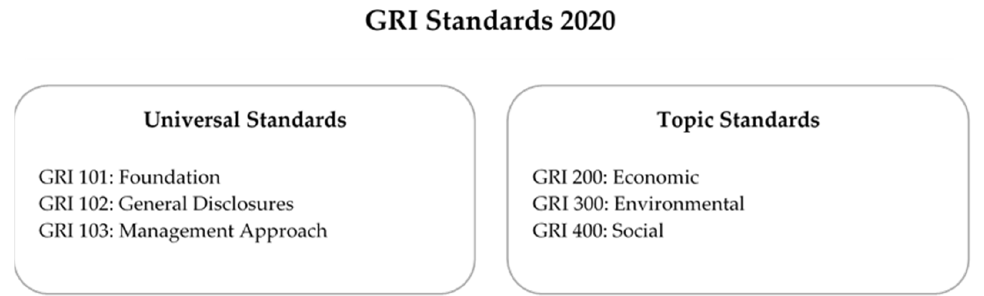
Figure 1. Overview of the GRI Standards 2020. Authors’ own figure adapted from Global Reporting Initiative (2020) and Global Reporting Initiative (n.d.b).